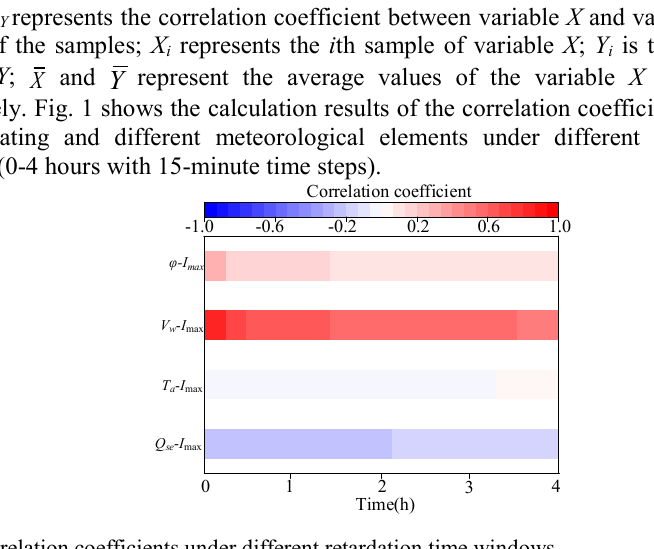
Fig. 1. Correlation coefficients under different retardation time windows